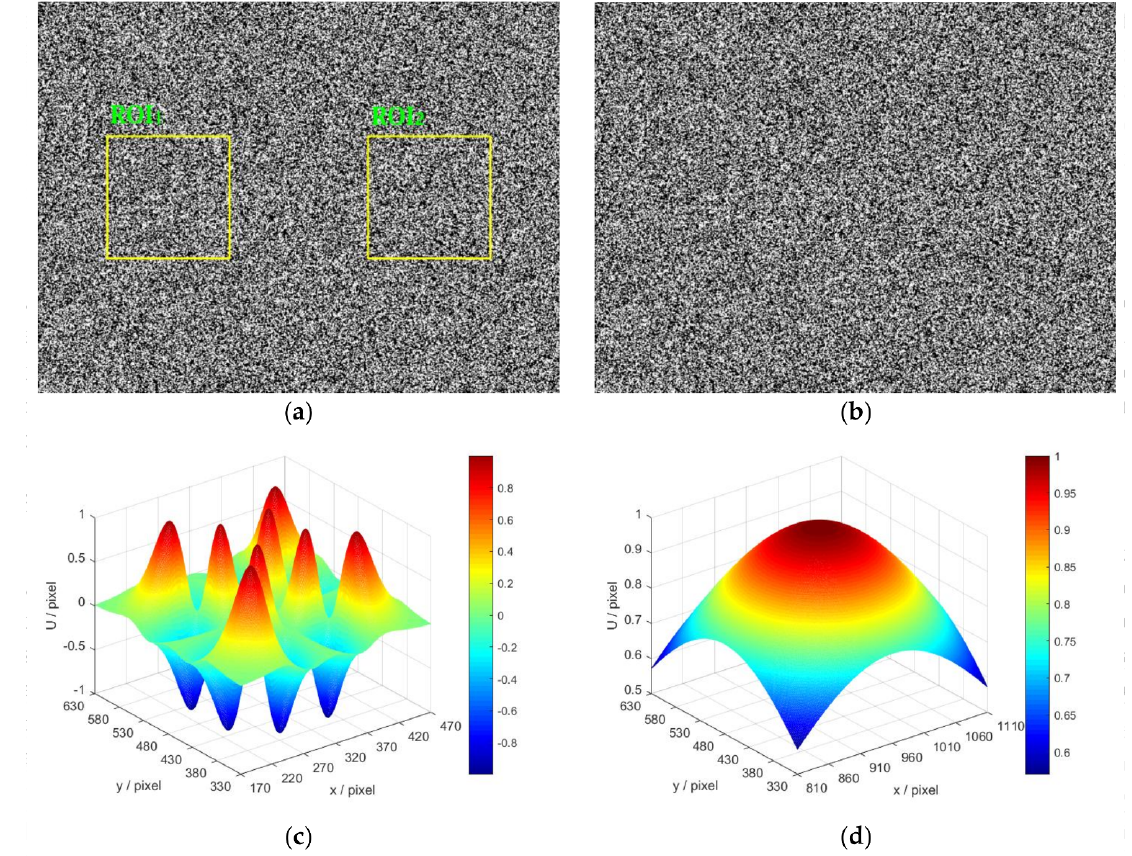
Figure 2. Synthetic speckle images: ( a ) Simulated reference image; ( b ) Simulated target image; ( c ) Theoretical displacements along x -axis of ROI 1 ; and ( d ) Theoretical displacements along x -axis of ROI 2